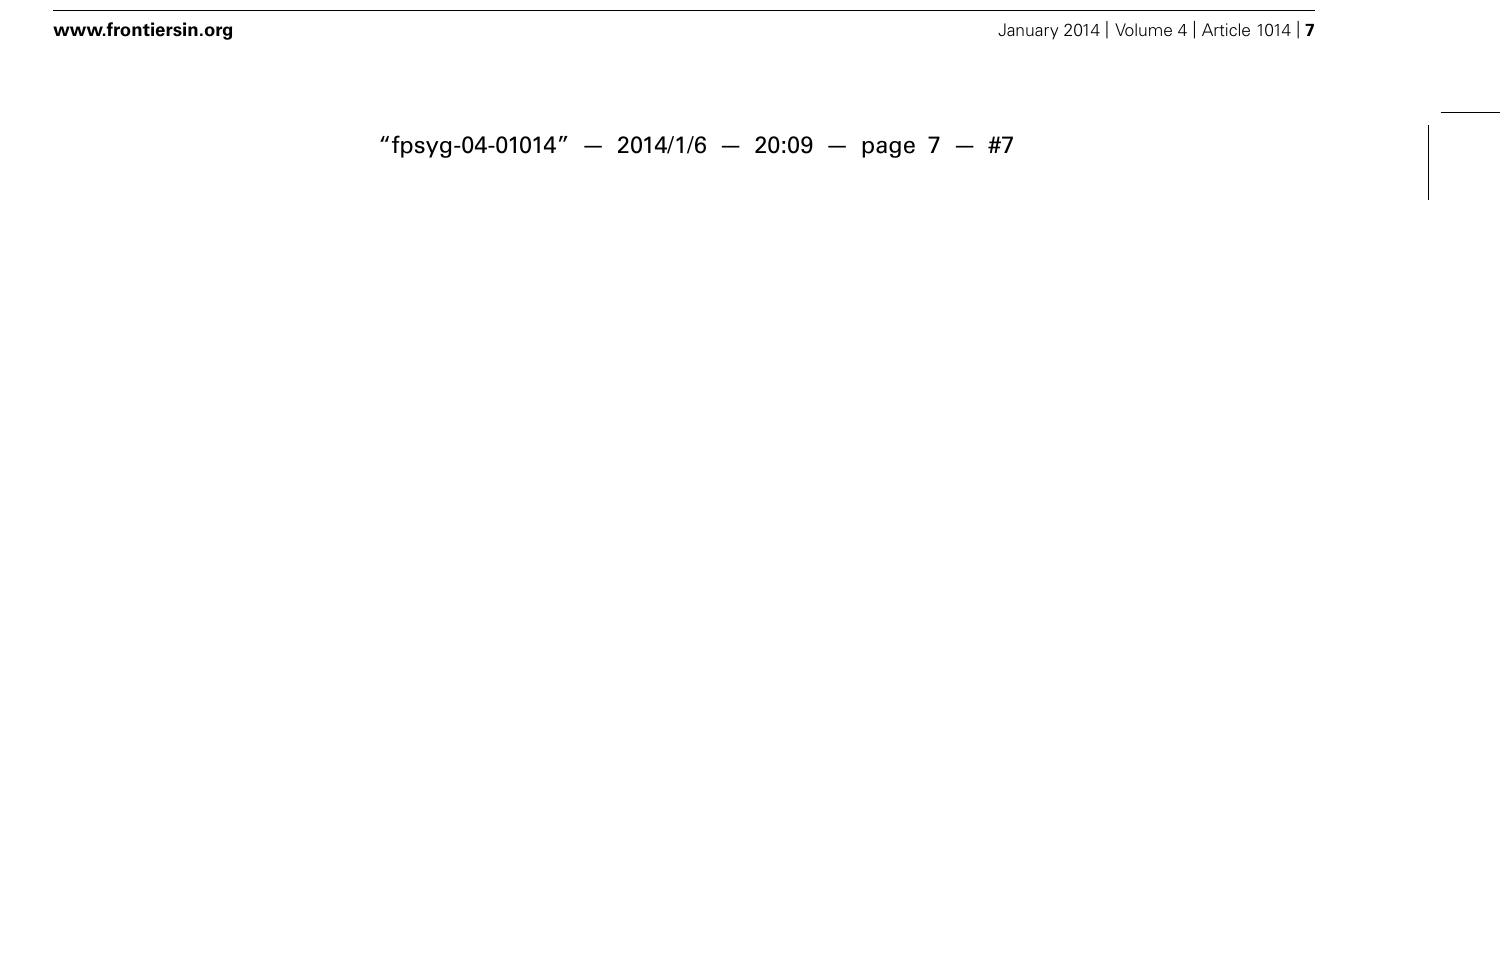
FIGURE 5 | Results of the cross-correlation model. Top row: The mean of the psychophysical results plotted in Figure 4 , across the three observers. Results are plotted (A) as a function of luminance bias (B) as a function of orientation bias and (C) as a two-dimensional heat-map, where color shows the proportion of “far” responses. Second row (D–F) : The results of the standard cross-correlation model. Unlike the psychophysical results, the model shows a strong effect of orientation, and an effect of luminance only when there is no orientation bias. Third